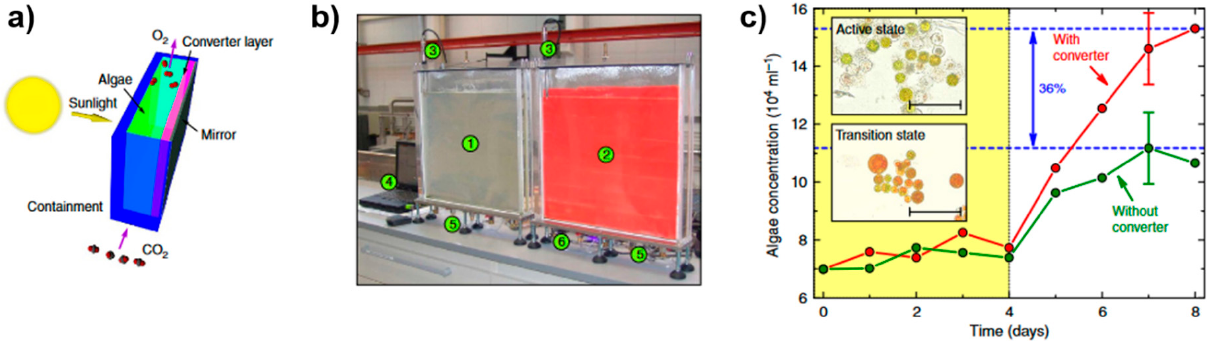
Figure 9. ( a ) Schematic of the backside LSC reactor for the growth of H. pluvialis, where it is partially absorbed. The backside of the reactor is coated with a layer of the red-emitting phosphor